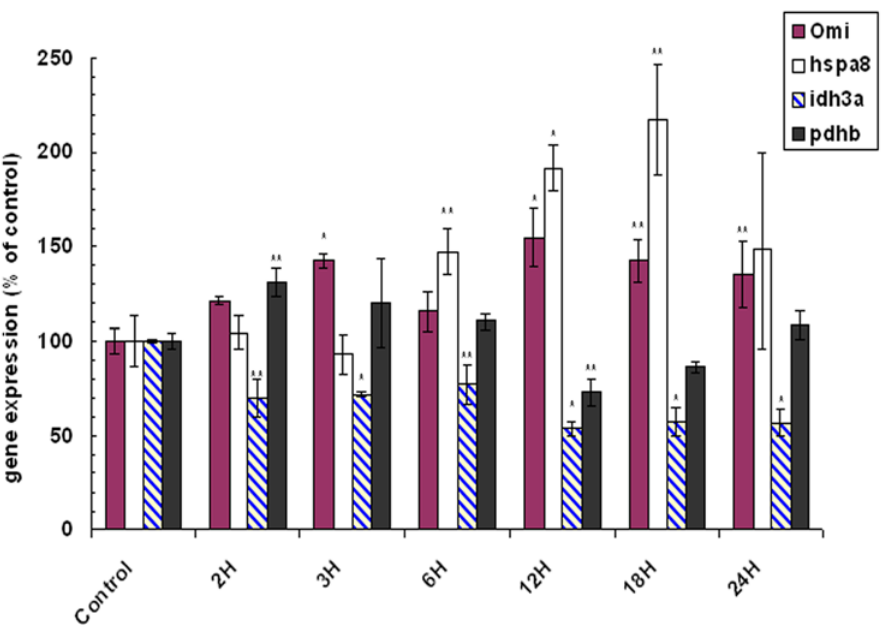
Figure 5. Gene expression studies of omi , idh3a,pdhb and hspa 8 in SH-SY5Y cells treated with 100 m M 6OHDA. Expression is normalized for b -actin and shown as a percentage of the untreated control (UnTx) where all data is the Mean 6 SEM: n $ 3, and where * indicates P # 0.005 and ** indicates P # 0.05 (using two tailed t-test analysis).